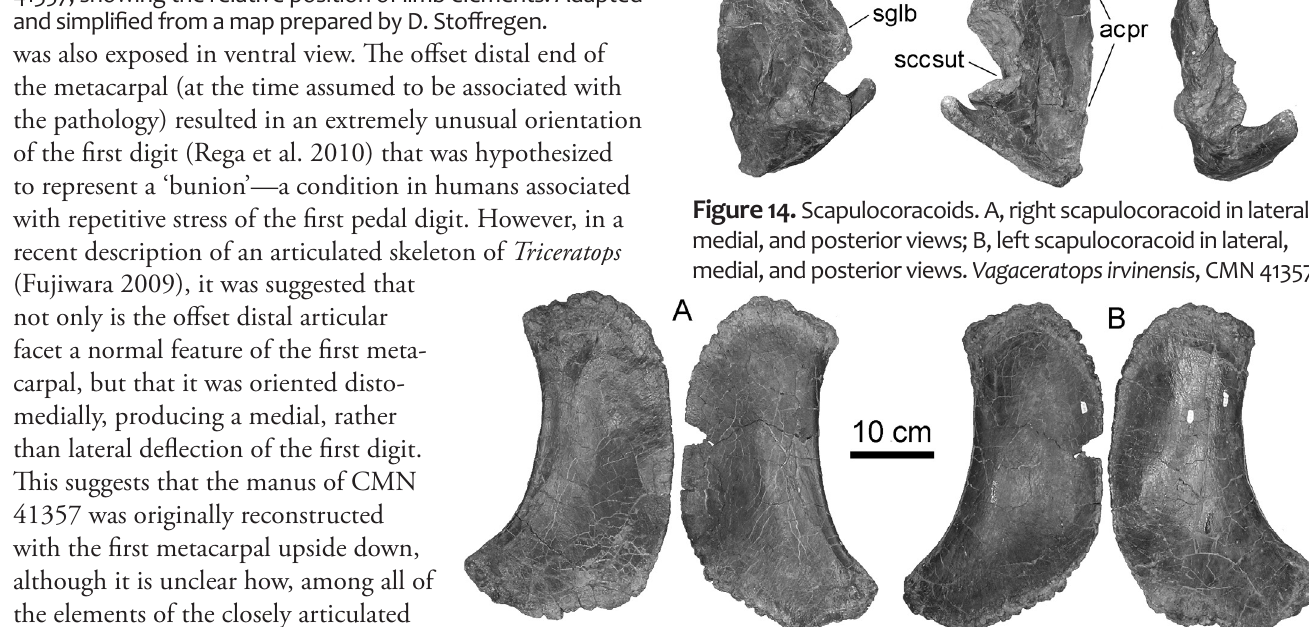
Figure 15. Left and right sternal plates in A, external and B, internal views. Vagaceratops irvinensis , CMN 41357.